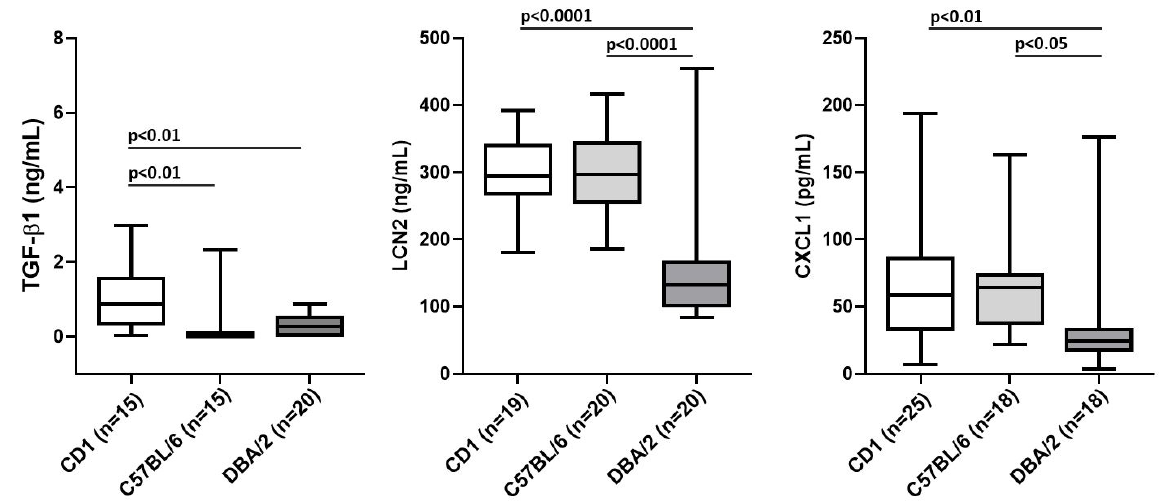
Figure 2. The serum from CD1 mice contains greater levels of proinflammatory cytokines than that from C57BL/6 or DBA/2 mice. The number of mice analyzed per experimental group is indicated by n. Since age and sex analyzed as independent variable did not reveal any statistically significant difference, results obtained at different ages in females and males were pooled (see Figure S4 and Tables S2–S4, Supplementary Materials). The number of mice analyzed in each group was: TGF- β 1: adult CD1 males n = 5; adult CD1females n = 3, old CD1 males n = 4; old CD1 females n = 3, total CD1 n = 15; adult C57BL/6 males n = 4; adult C57BL/6 females n = 3, old C57BL/6 males n = 5; old C57BL/6 females n = 3, total C57BL/6 n = 15; adult DBA/2 males n = 5; adult DBA/2 females n = 5, old DBA/2 males n = 5; old DBA/2 females n = 5, total DBA/2 n = 20; LCN2: adult CD1 males n = 5; adult CD1 females n = 4, old CD1 males n = 5; old CD1 females n = 5, total CD1 n = 19; adult C57BL/6 males n = 5; adult C57BL/6 females n = 5, old C57BL/6 males n = 5; old C57BL/6 females n = 5, total C57BL/6 n = 20; adult DBA/2 males n = 5; adult DBA/2 females n = 5, old DBA/2 males n = 5, old DBA/2 females n = 5; total DBA/2 n = 20; CXCL1: adult CD1 males n = 8; adult CD1 females n = 6, old CD1 males n = 6; old CD1 females n = 5, total CD1 n = 25; adult C57BL/6 males n = 3; adult C57BL/6 females n = 5, old C57BL/6 males n = 5; old C57BL/6 females n = 5, total C57BL/6 n = 18; adult DBA/2 males n = 5, adult DBA/2 females n = 4, old DBA/2 males n = 5; old DBA/2 females n = 4, total DBA/2 n = 18. P values were calculated with Tukey multiple comparison test and statistically significant differences ( p < 0.05) indicated in the panels. Abbreviations: TGF- β 1, transforming growth factor β 1; LCN2, lipocalin-2.